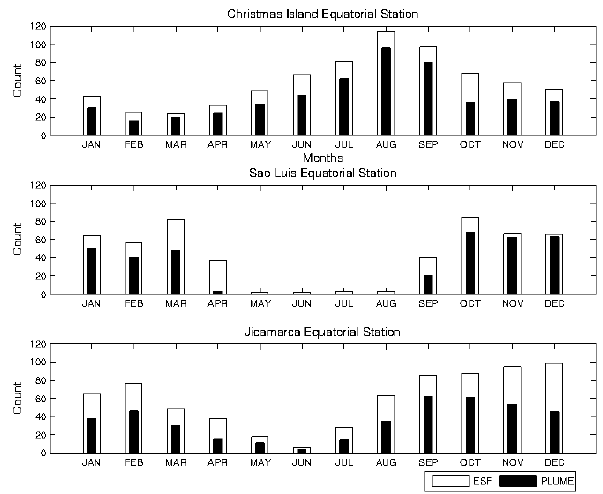
Fig. 3. Seasonal occurrence of spread F irregularities combined for over the period in study (irrespective of solar flux). In white bars are the spread F events, and in black bars the plume events observed over each equatorial